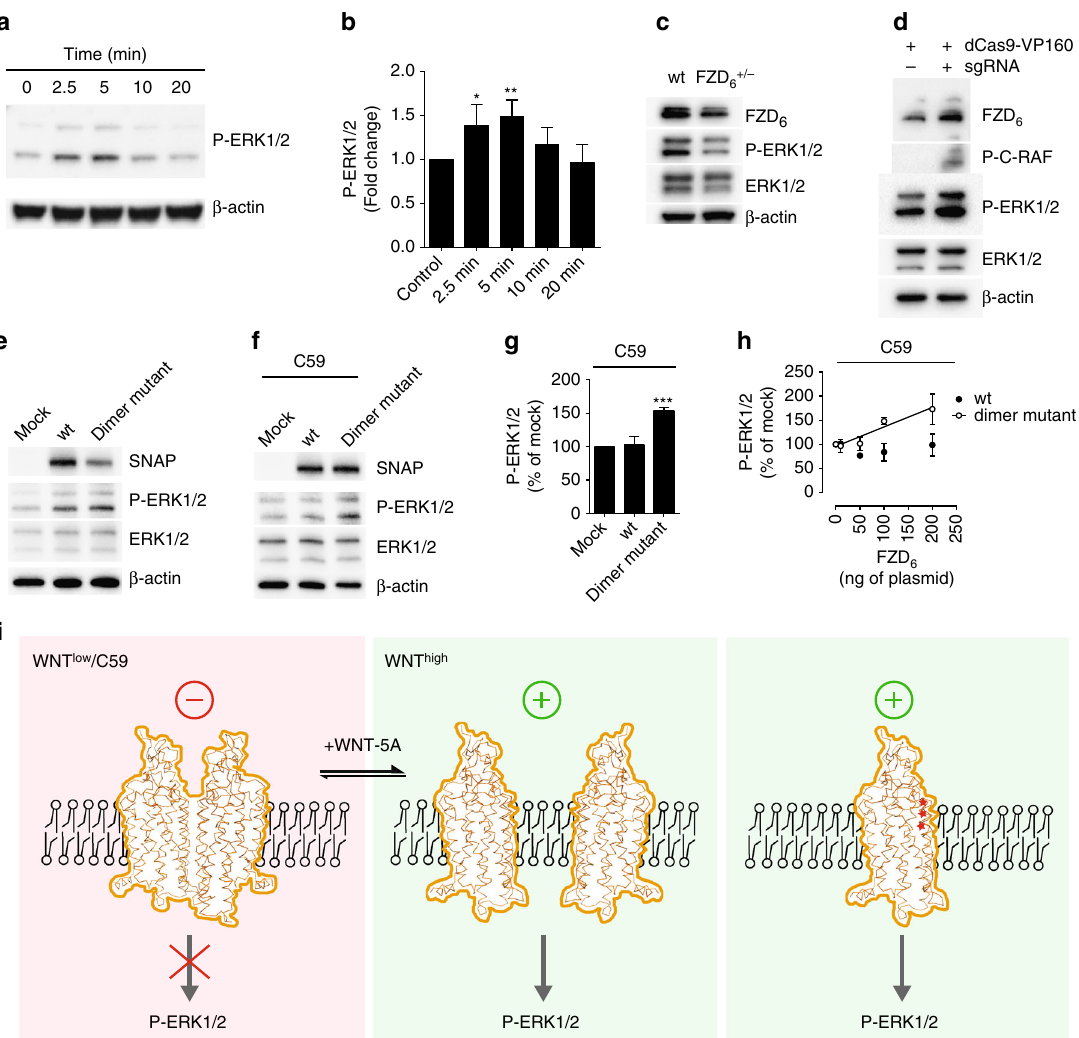
Fig. 6 Relationship between FZD 6 dimerization and phosphorylation of ERK1/2. a Mouse lung epithelial (MLE-12) cells were stimulated with